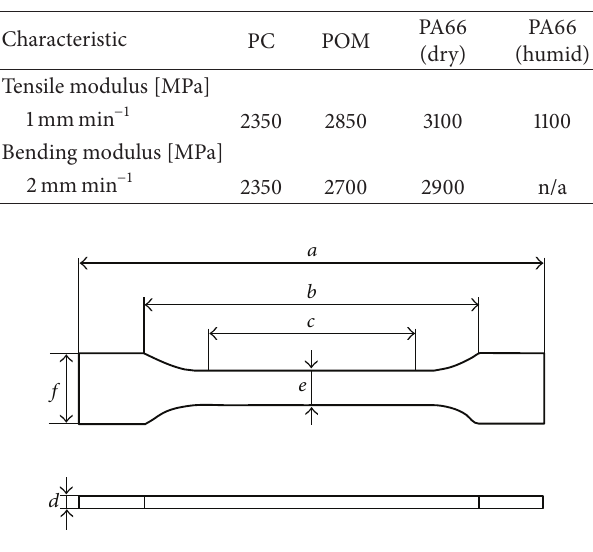
Figure 1: Geometry of the tensile